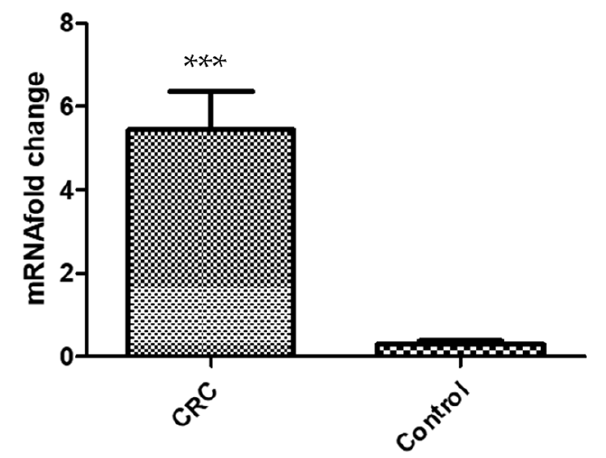
Figure 2. The relative CTLA-4 gene expression was estimated using the 2 − ∆∆ Ct method and normal- ized to the average of the GAPDH housekeeping gene. (mean ± SE) (*** p < 0.001).